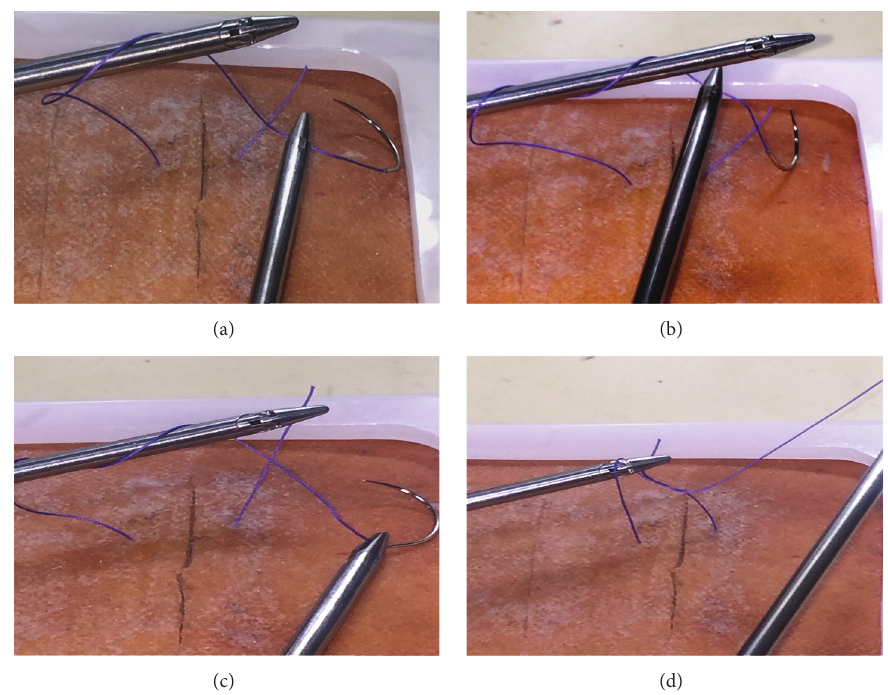
Figure 1: (a) (Step 1 ) Starting the loop of suture by right hand needle driver over the left hand needle driver. (b) (Step 2 ) Making two loops over the left hand needle driver. (c) (Step 3 ) The left hand needle driver catching the tail end of the suture through the loops. (d) (Step 4 ) First throw of knot completed by pulling the tail end of suture through the